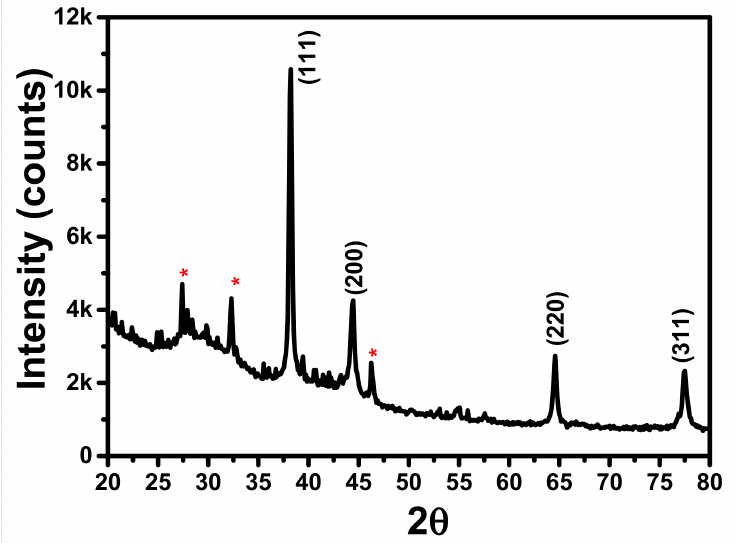
Figure 3. XRD pattern of LS–Ag NPs synthesized under optimized conditions where minor undesig- nated peaks (denoted with stars).